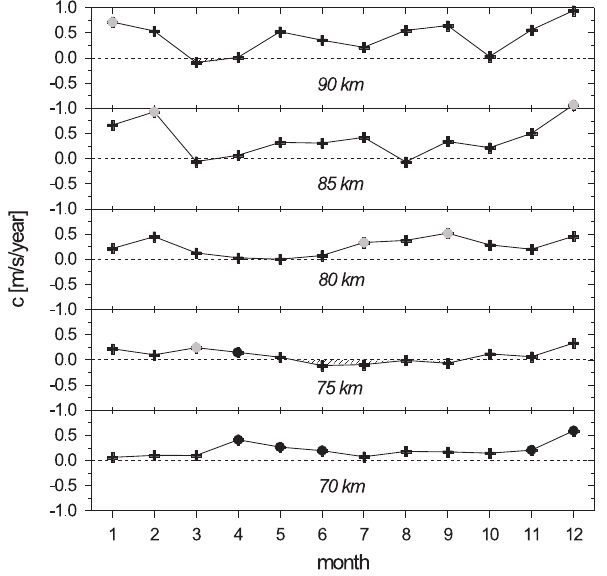
Fig. 18. Seasonal variation of the trend of the semidiurnal tidal amplitude at Juliusruh (partial regression coefficient c due to Eq. 1) for different heights. The significance levels χ are marked by black dots ( χ ≥ 95%), grey dots ( χ ≥ 90%), and crosses ( χ< 90%).